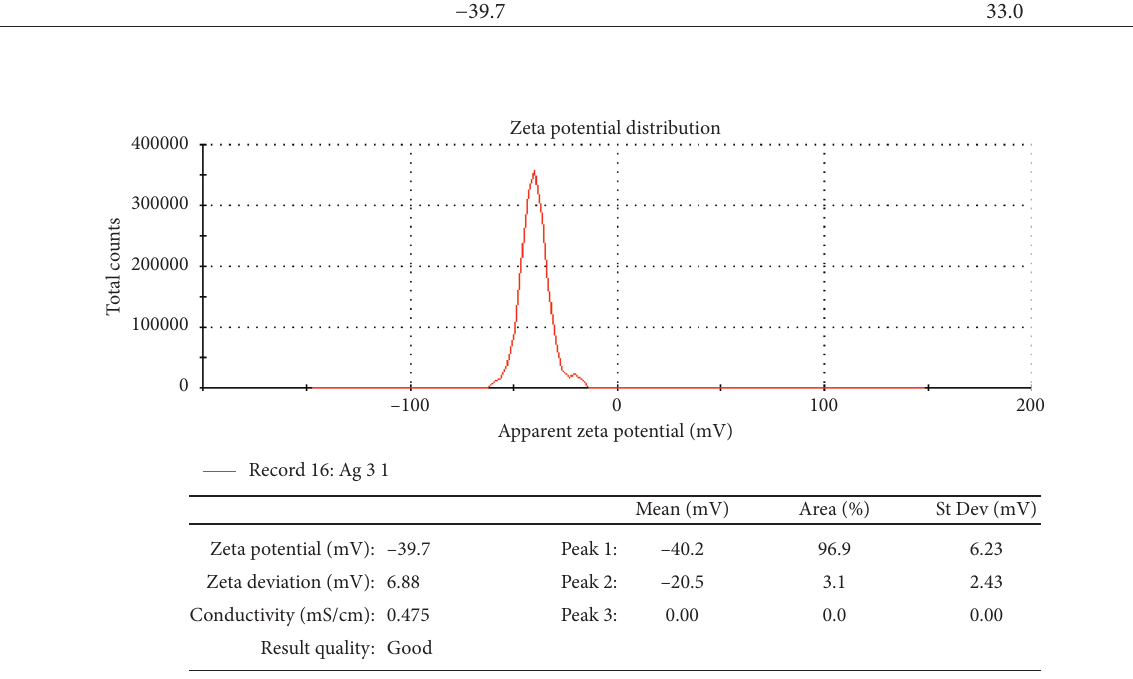
3 1.0mmol/L for